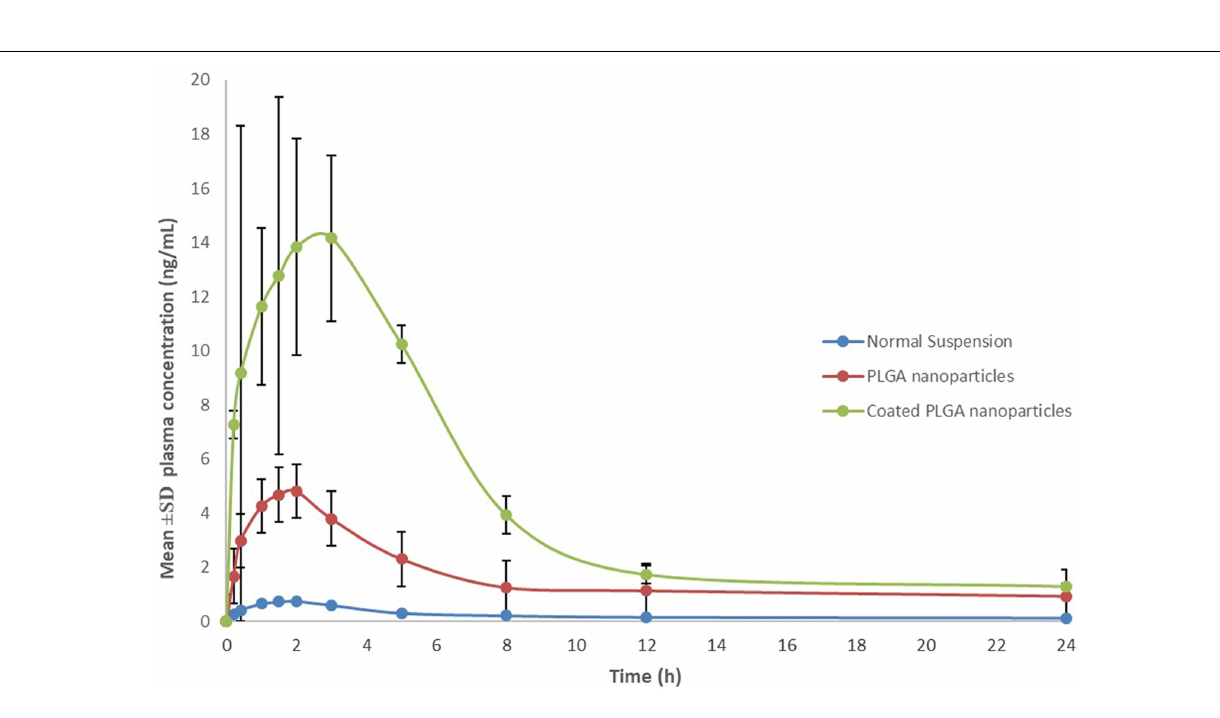
FIGURE 8 | Mean ± SD plasma concentration vs. time profiles of